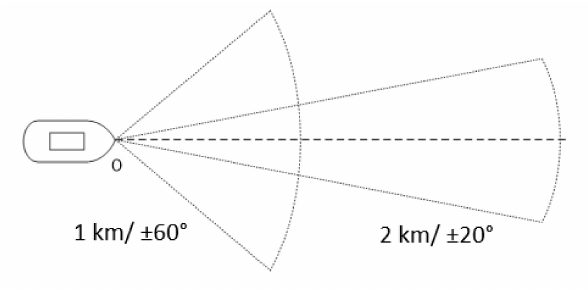
Figure 3. Radar detection